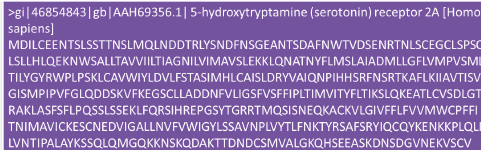
Figure 4: FASTA sequence of 5-HT receptor (PDB IDs: 2Y00, 2Y01, 2Y02, 2Y03, 2Y04, and A2A), adenosine receptor (PDB ID: 3QAK) and rhodopsin (PDB ID: